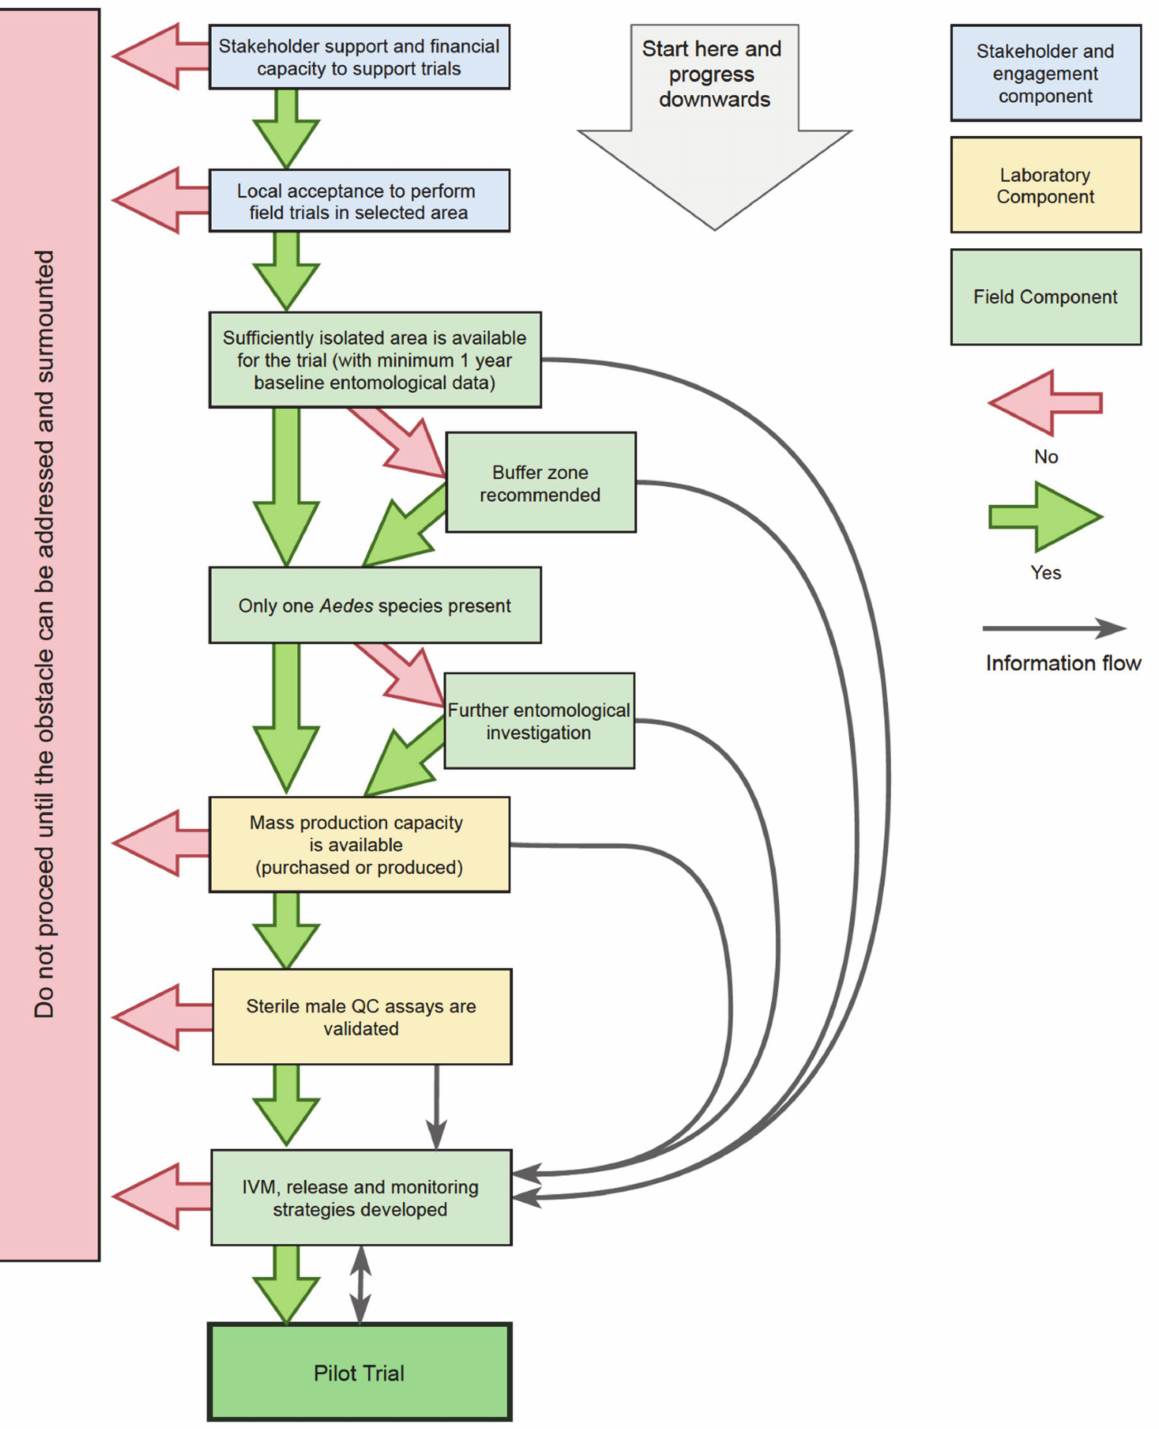
Figure 1. A decision tree for progression towards the implementation of a sterile insect technique (SIT) pilot field trial for vector mosquito